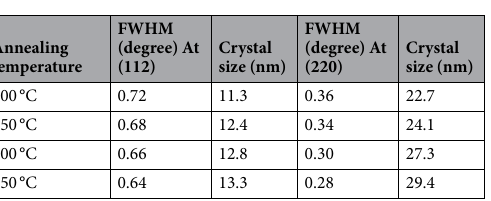
Table 1. Comparison of FWHM and crystal size of sputter grown CZTS with annealing